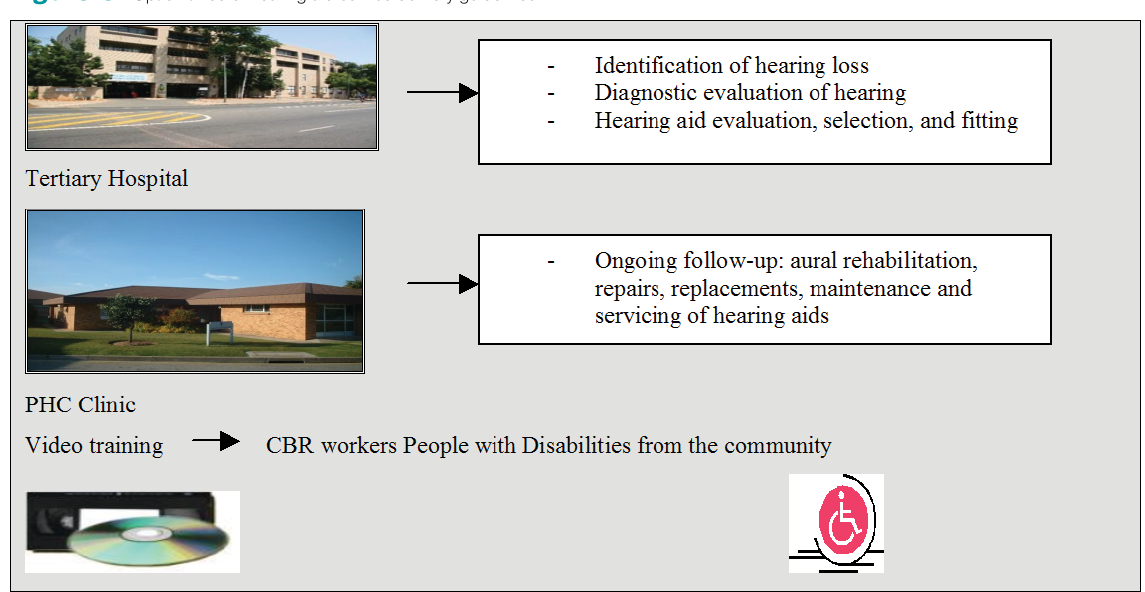
Figure 6. Option three of hearing aid service delivery